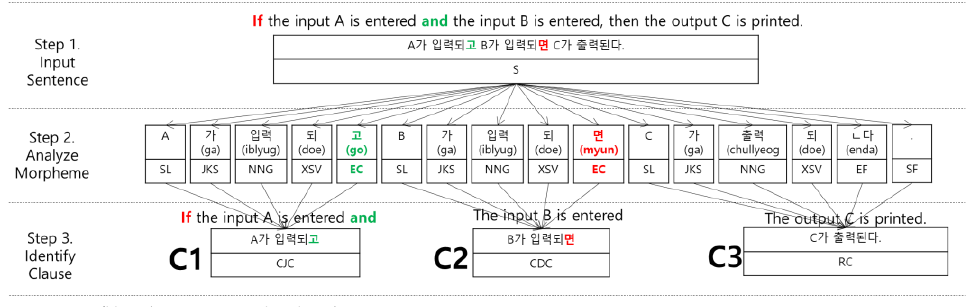
Figure 7. Three clauses’ Identification (this order of C1 ->C2->C3) in the sentence.